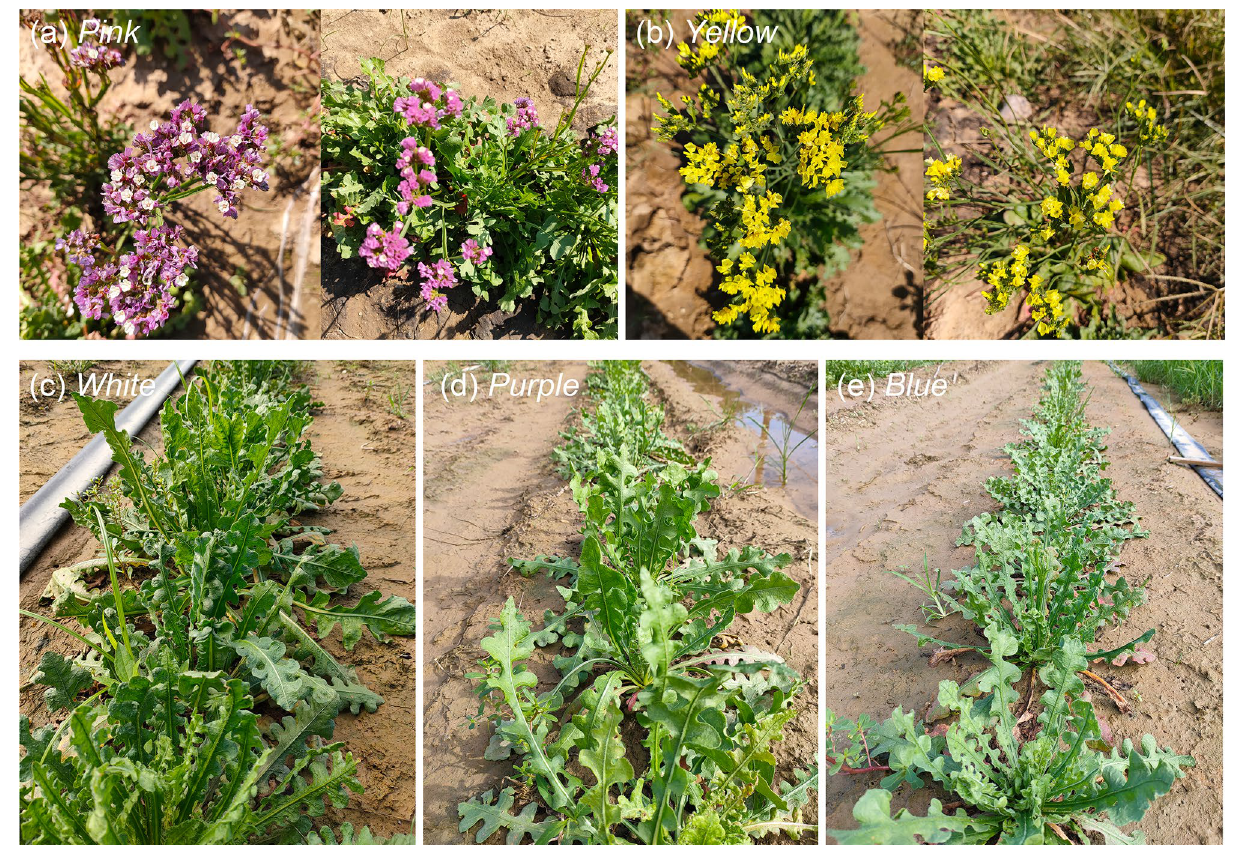
Figure 10. Growth of five varieties of Limonium sinuatum in saline soil.